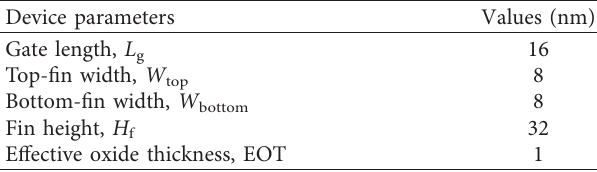
Table 3: Device parameters of fin field-effect transistors. Device parameters